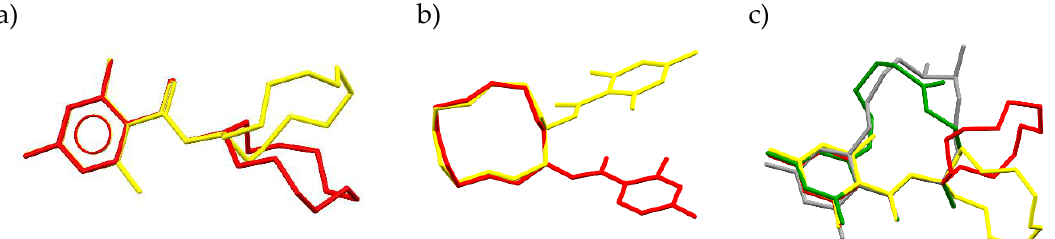
Figure 5. Crystal structures of CDHB: Molecule 1 ( a ), Molecule 2 ( b ).